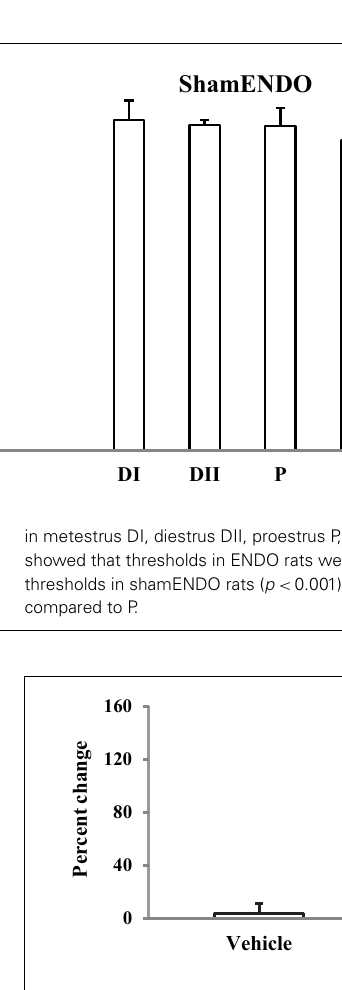
FIGURE 4 | Effect of 10mg/kg of Indomethacin injected s.c. in the neck on theVMR threshold. * p < 0.05 compared to